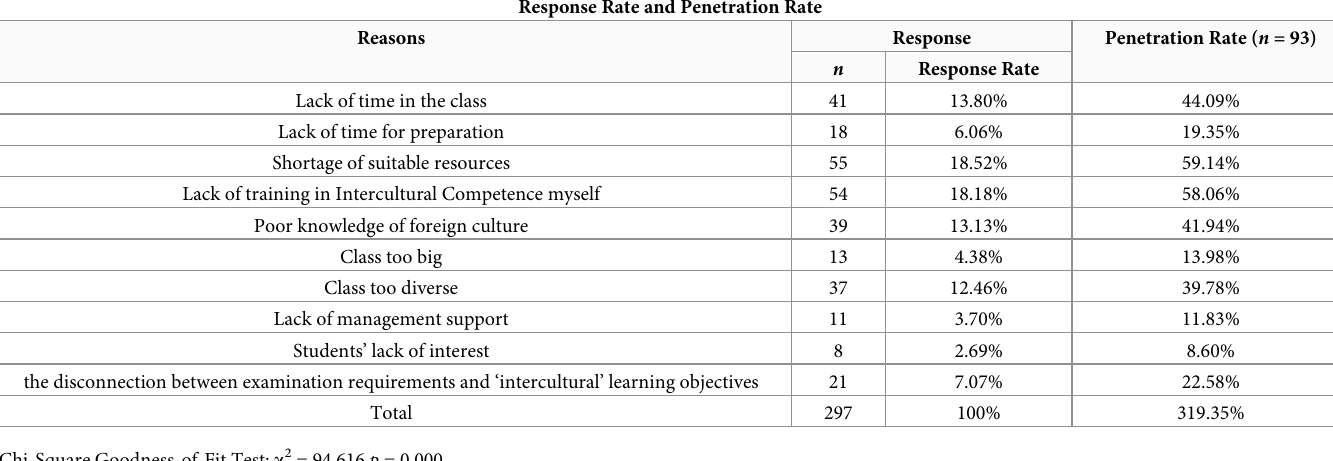
Table 7. Reasons for not devote more time to